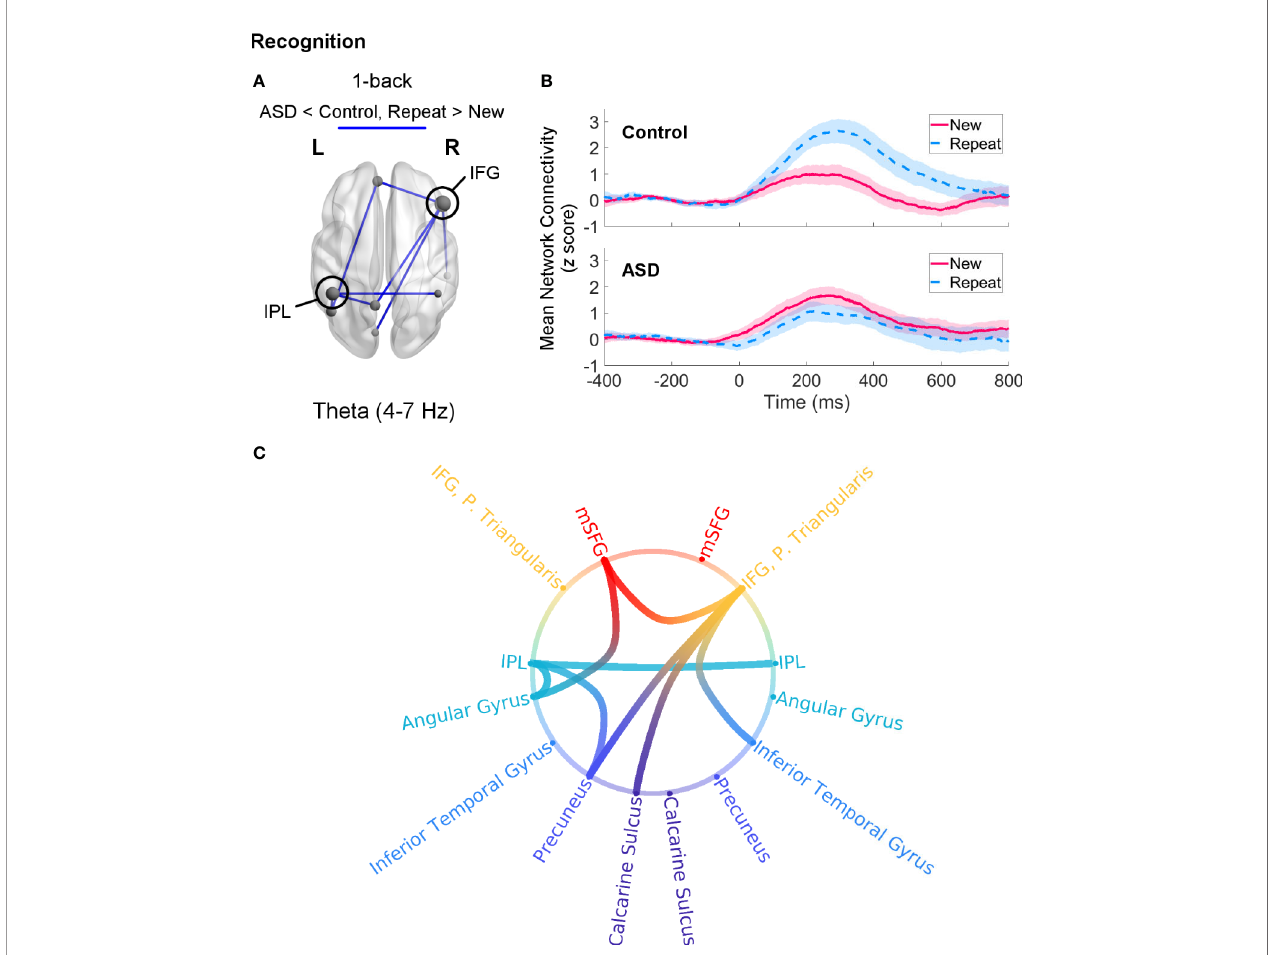
FIGURE 6 | Theta-band connectivity in adults with autism spectrum disorder (ASD) compared to controls during recognition of novel visual stimuli (Repeat versus New trials, 0 – 400 ms, poststimulus onset) in the 1-back load. (A) Adults with ASD showed signi fi cantly reduced ( p FWE = 0.046) theta-band connectivity in a network with hubs in the right IFG and left IPL. Node size is scaled by number of connections. (B) Mean connectivity in this network between − 400 – 800 ms in the control (top) and ASD (bottom) groups. Connectivity values are given as z scores. (C) Network connectivity represented as a circle plot. Nodes are colour-coded in the following manner, from top to bottom: medial frontal structures (red), frontal areas (orange), parietal regions (turquoise), temporal areas (blue), medial parietal structures (dark blue), occipital areas